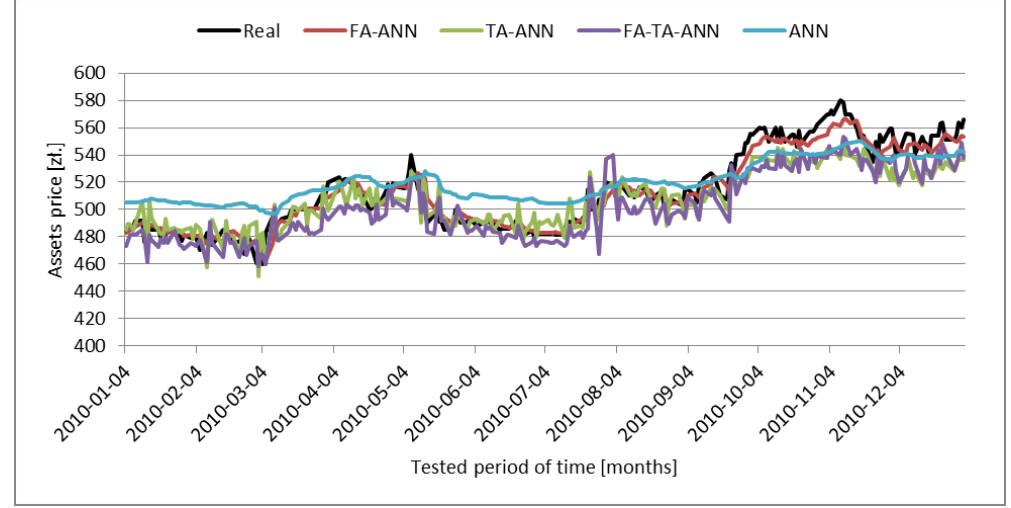
Figure 4. Short-term forecast of ANN-based models and the real CLOSE value for ŻYWIEC SA in 2010.